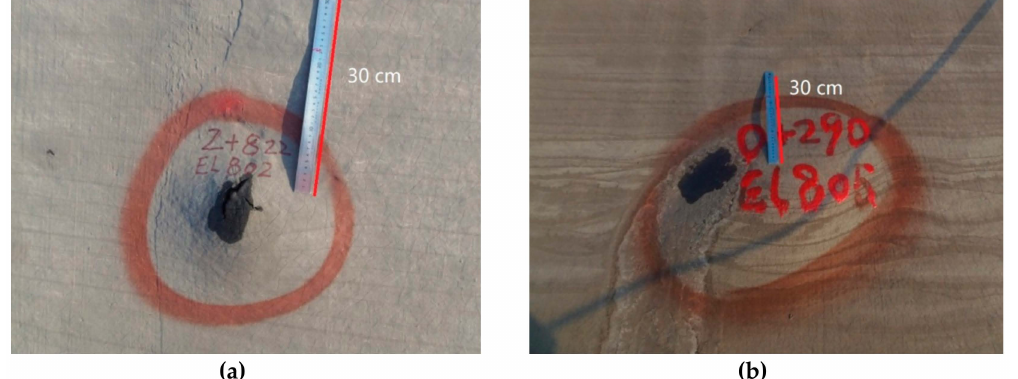
Figure 4. Blister on the asphalt facing. ( a ) cracked at the face; ( b )